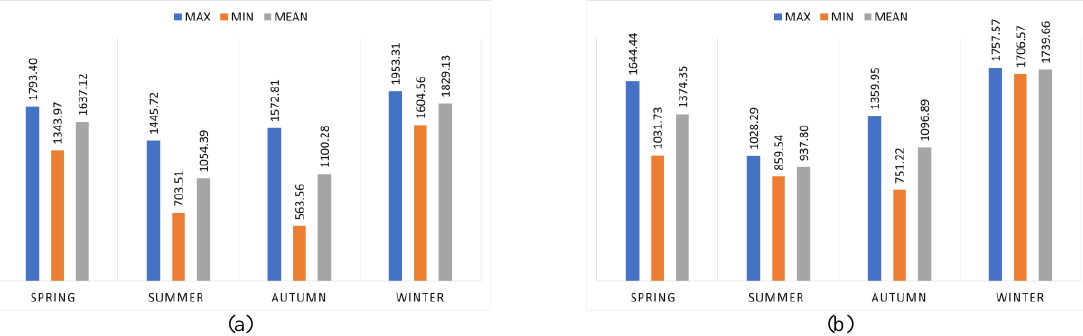
Figure 5. Seasonal Mean, Maximum, and Minimum water area in ISW during 2019-2021 for (a) HA and (b) RF